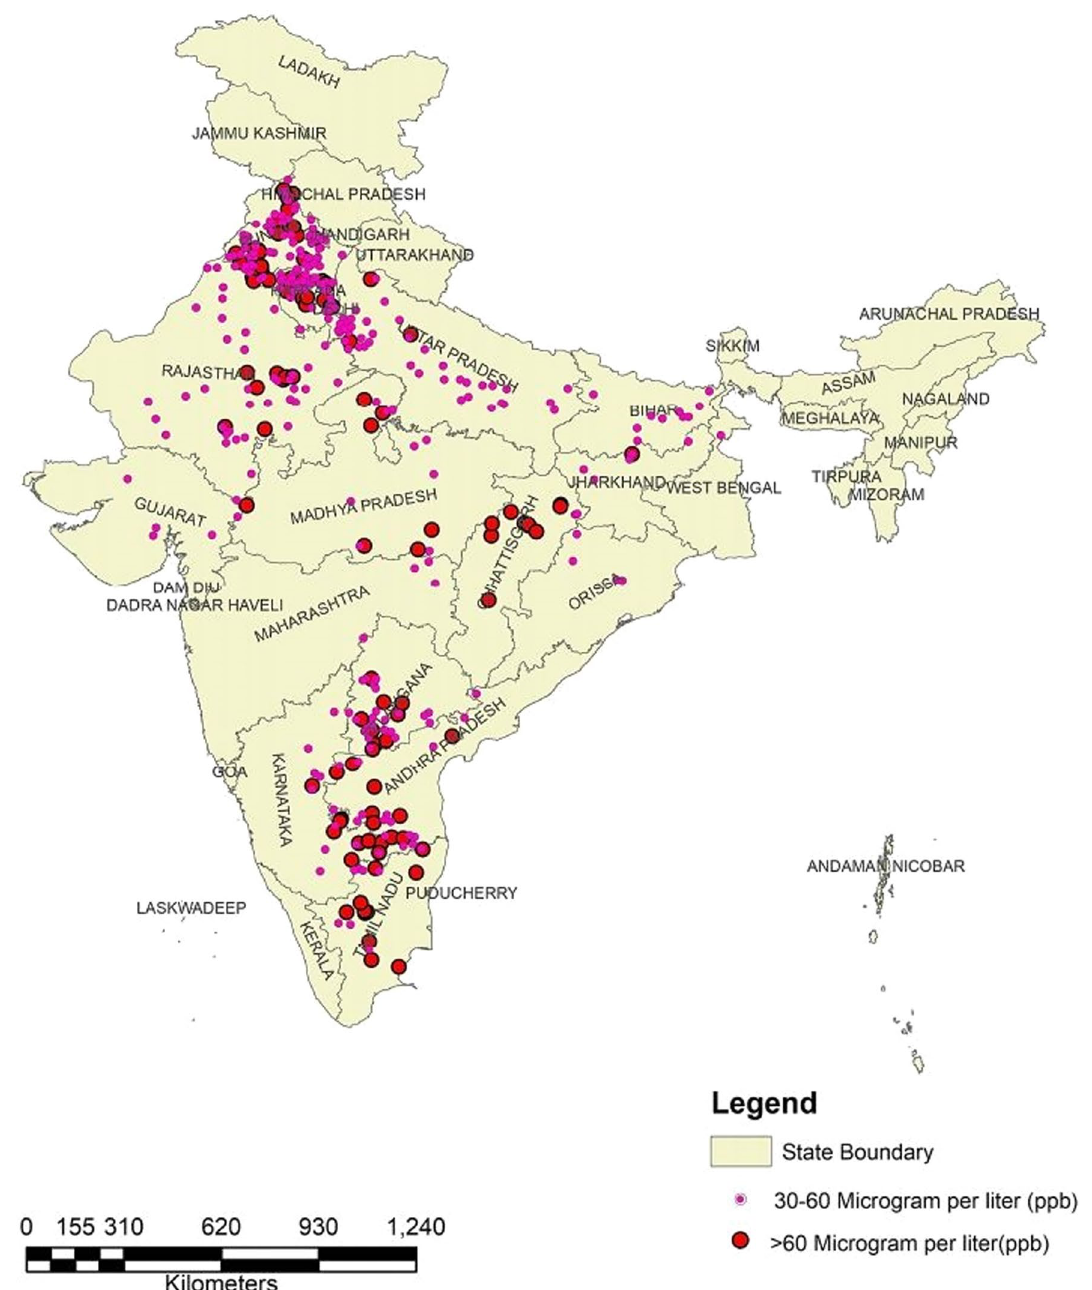
Fig. 7 Location of high Uranium concentrations in shallow aquifers in India ( Source CGWB